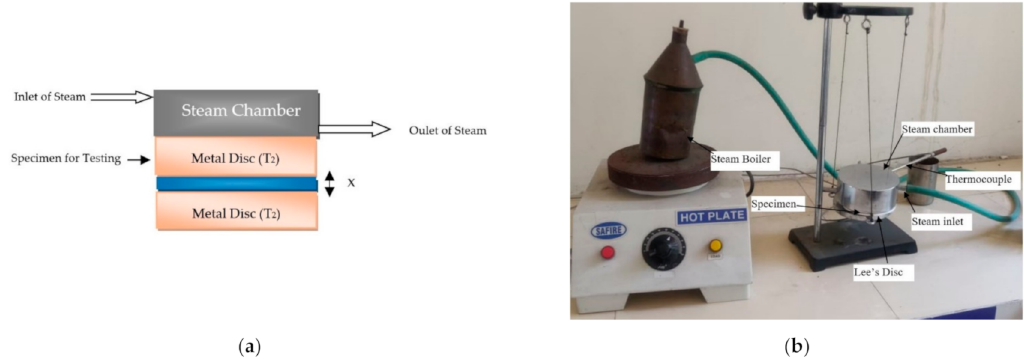
Figure 6. ( a ) Thermal conductivity measurement principle; ( b ) Lee’s Disc Experimental